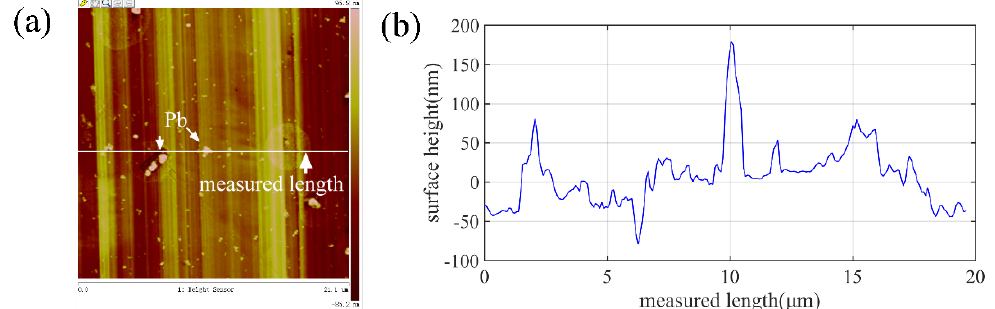
Figure 17. The nanoscale surface characteristics of the machined Cu measured by AFM, ( a ) surface topography of the machined surface and ( b ) the cross-sectional profile of the picked measured length.